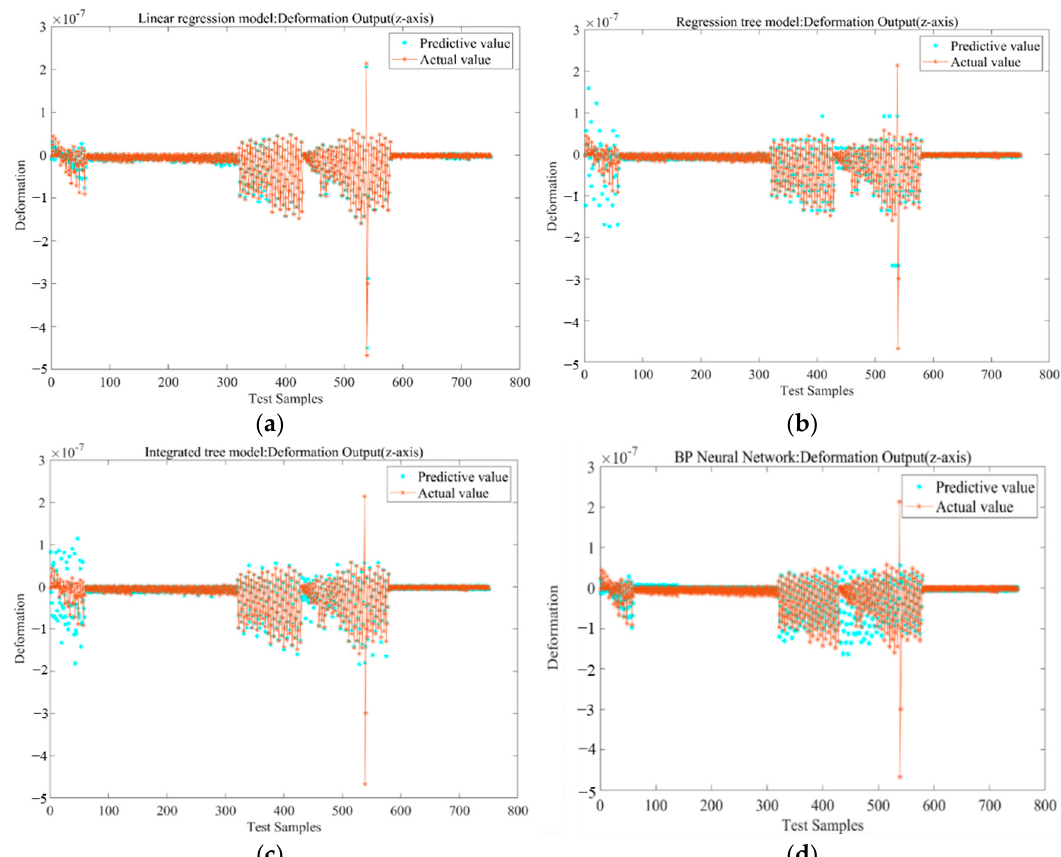
Figure 4. Output response of each training model: ( a ) Linear regression model; ( b ) Regression tree model; ( c ) Integration Tree Model; ( d ) BP neural network model.